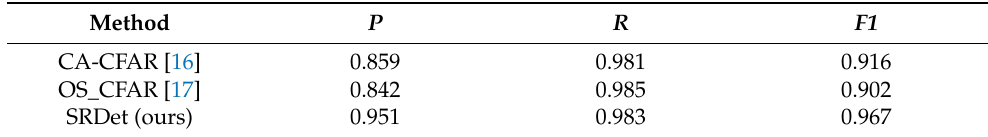
Table 7. Comparison of CFAR detection